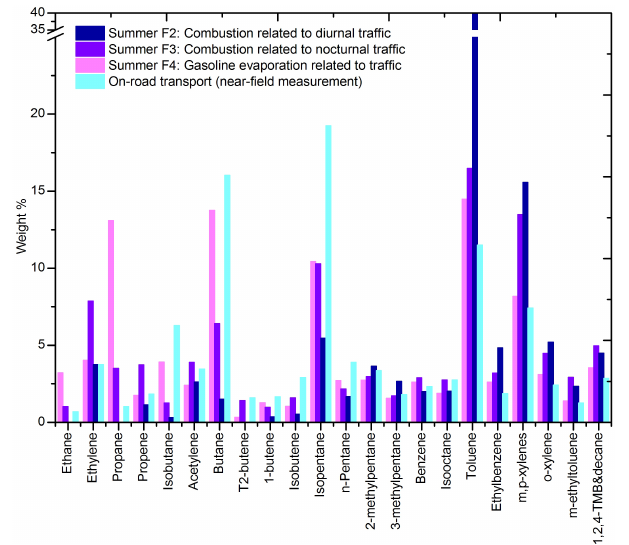
Figure 9. Source composition profiles (wt%) of combustion related to diurnal and nocturnal traffic (F2 and F3) and gasoline evapora- tion (F4) in summer compared to the on-road transport profile es- tablished by near-field measurements (Salameh et al., 2014).